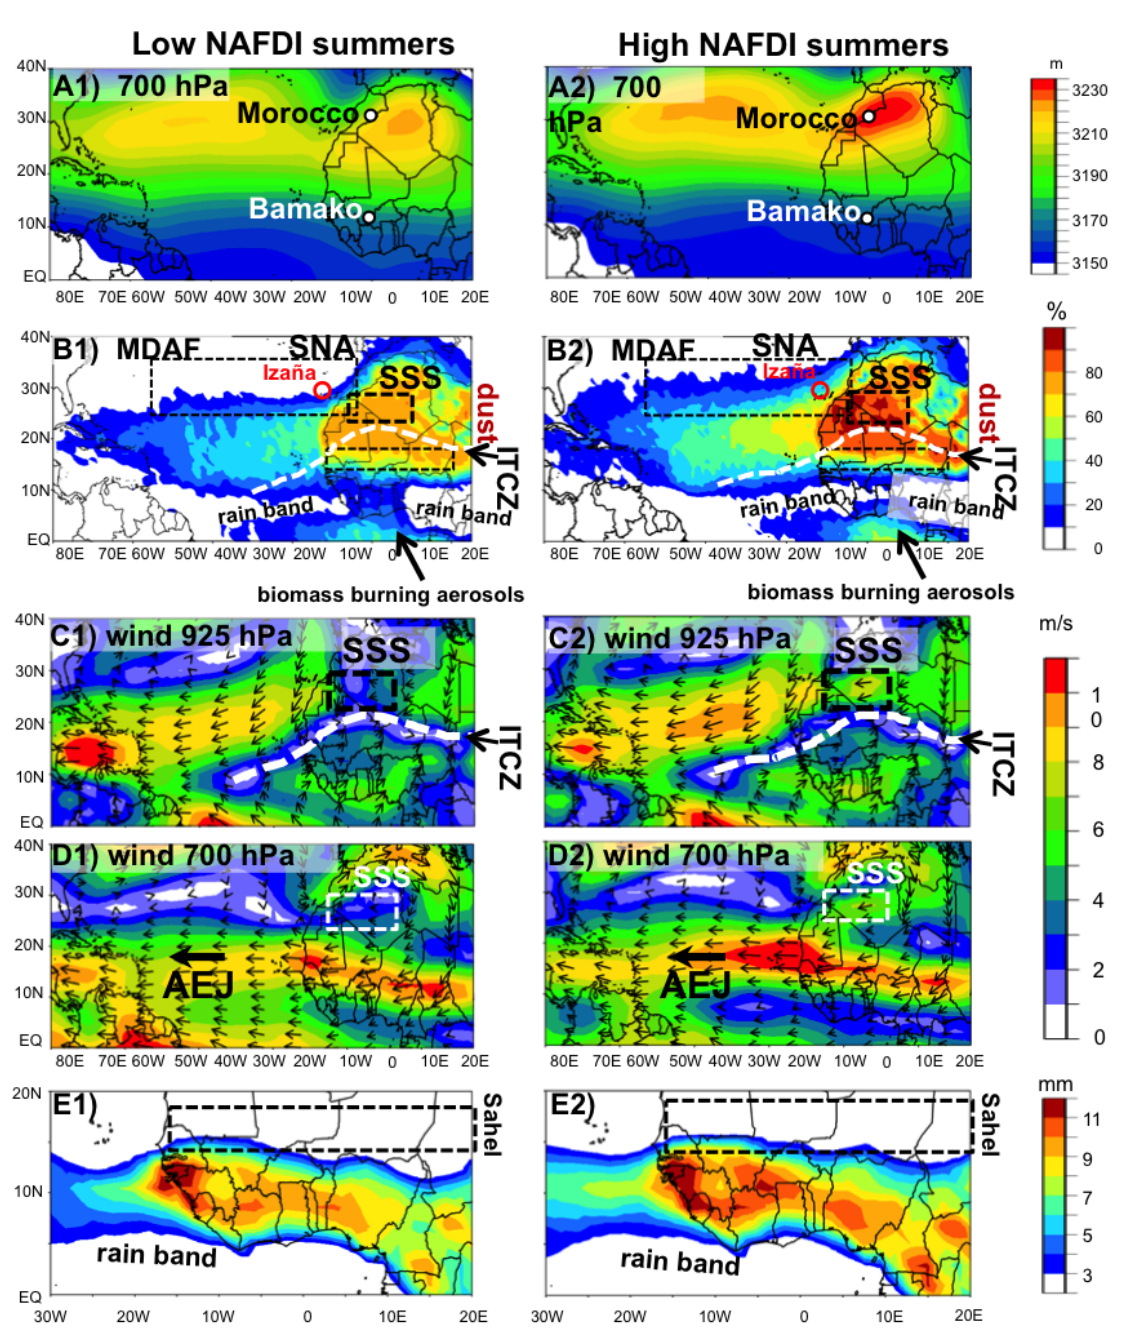
Figure 4. North African dipole and spatial distribution of dust and meteorological fields averaged in low and high NAFDI summers. The low NAFDI group includes the summers with the four lowest NAFDI values in the period 1987–2014 (1987, 1996, 1997 and 2006 are − 2.79, − 2.04, − 3.19 and − 1.54, respectively). The high NAFDI group includes the summers with the four highest NAFDI values in the period 1987–2014 (1988, 2000, 2008 and 2012 are + 0.68, + 0.83, + 1.01 and + 2.29, respectively). Only summers for which satellite AI data are available were considered for this low and high NAFDI summers selection (i.e., 1993–1995 and 2002–2004 were not included). (a) Height of 700hPa geopotential highlighting the location of the two regions used for determining the NAFDI. (b) MDAF at the north of the rain band (data at the south of the tropical rain band are due to biomass burning aerosols from southern Africa) (Prospero et al., 2002). Mean winds at (c) 925hPa ( ≈ 800ma.s.l.) and (d) 700hPa ( ≈ 3000ma.s.l.). (e) Mean precipitation rates. The location of the Inter-Tropical Convergence Zone (ITCZ), the subtropical Saharan Stripe (SSS), the African Easterly Jet (AEJ) and the subtropical North Atlantic (SNA) are